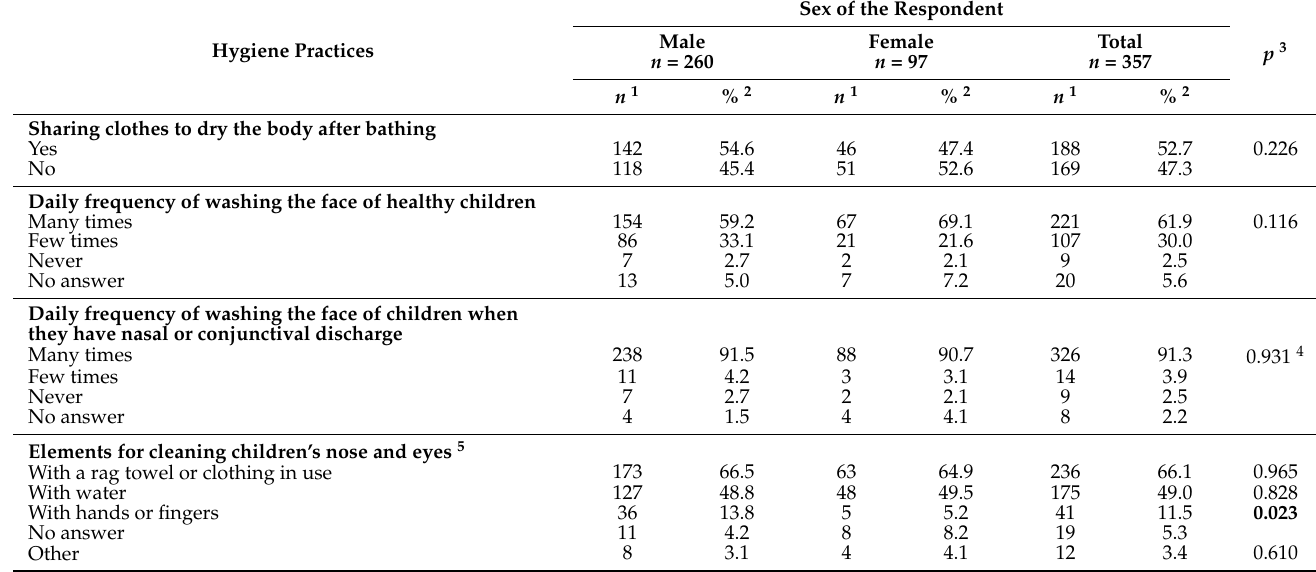
Table 4. Hygiene practices for adults and children according to sex in the trachoma knowledge, attitude, and practice